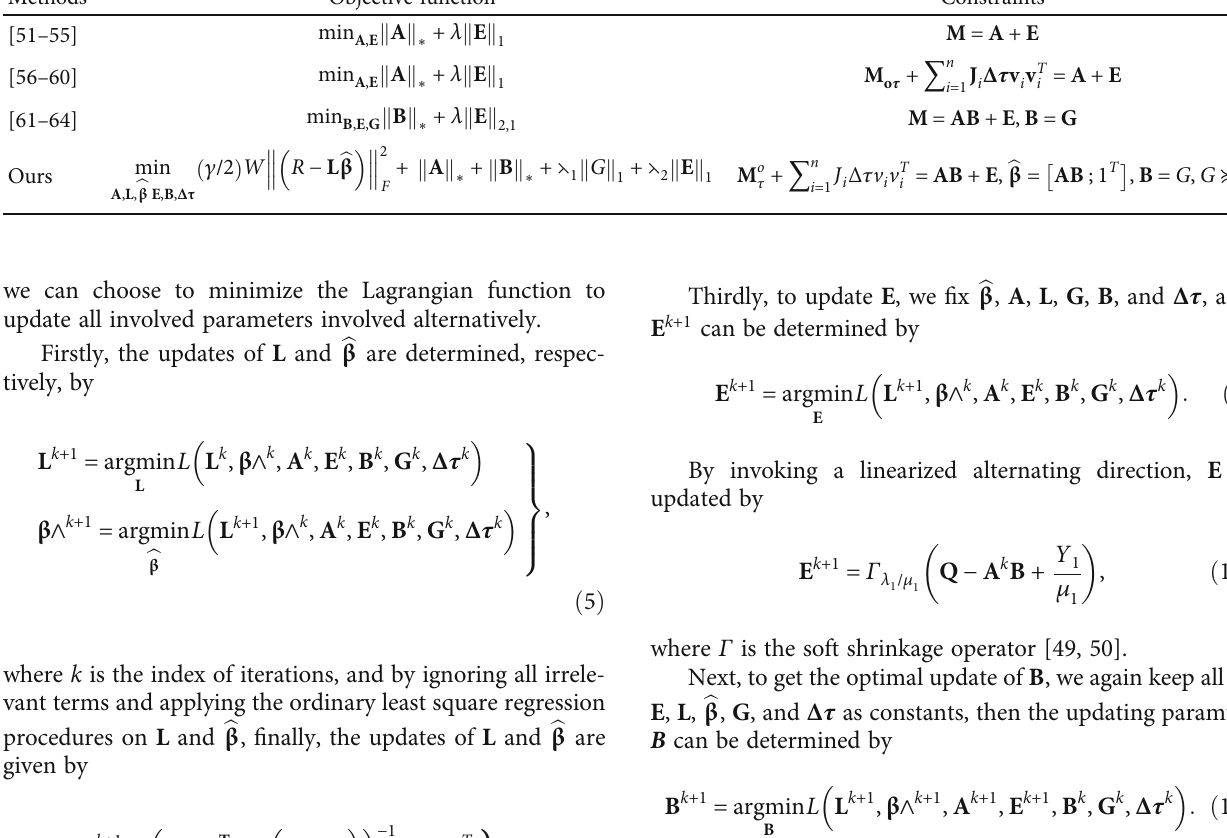
Table 1: Comparison of the proposed approach with other related algorithms in terms of the objective function and constraints.